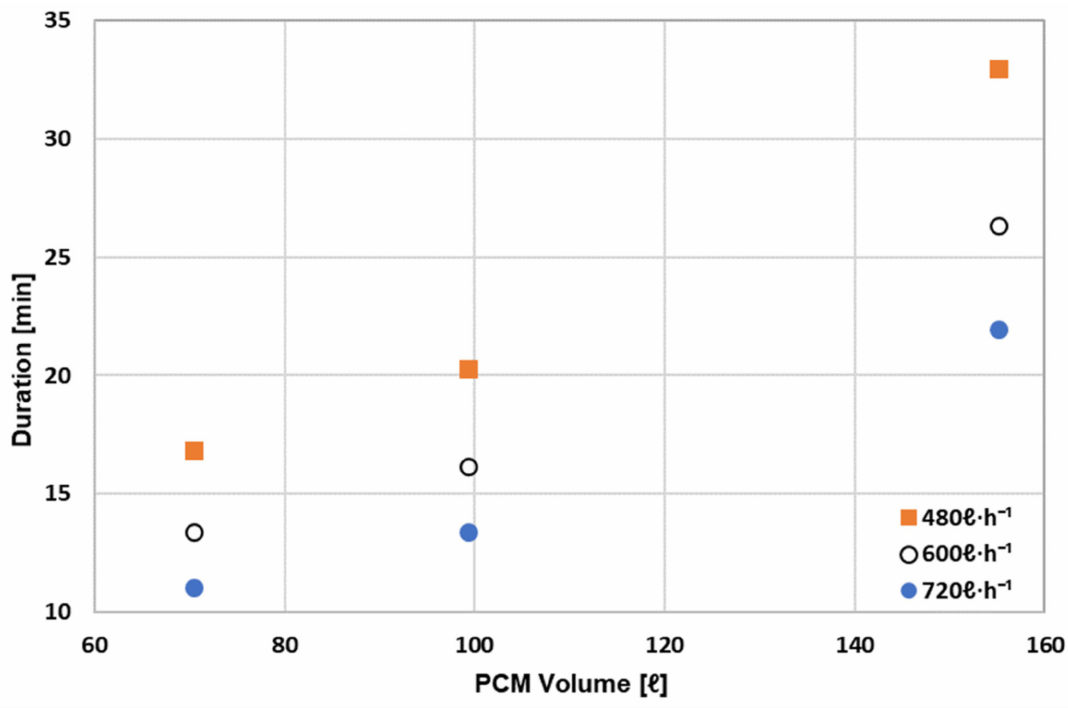
Figure 15. Duration of domestic hot water production versus PCM volume for P53 and three different mass flow rates.